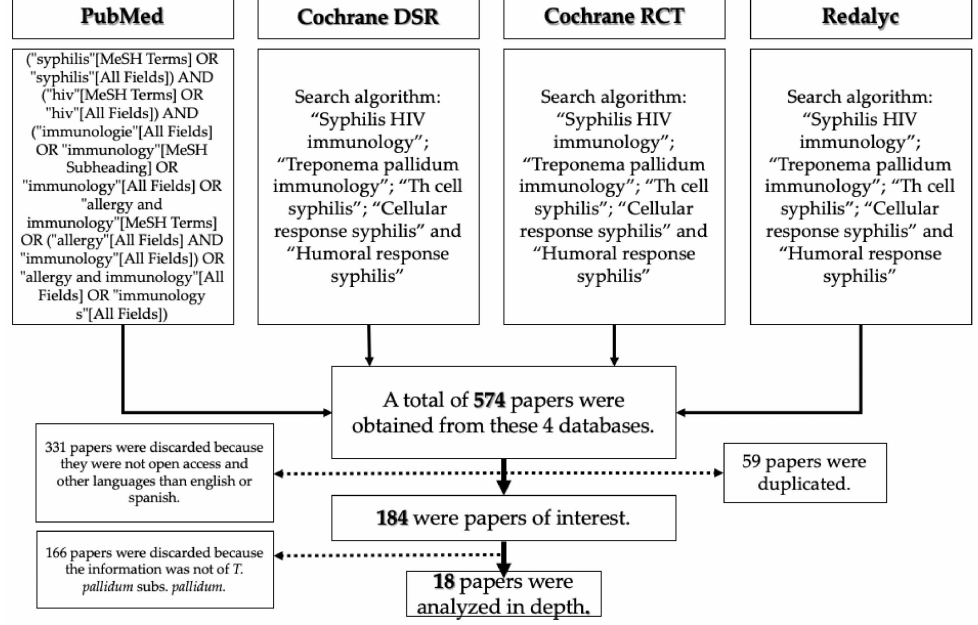
Figure 1. Election and methodology in four different databases for a systematic